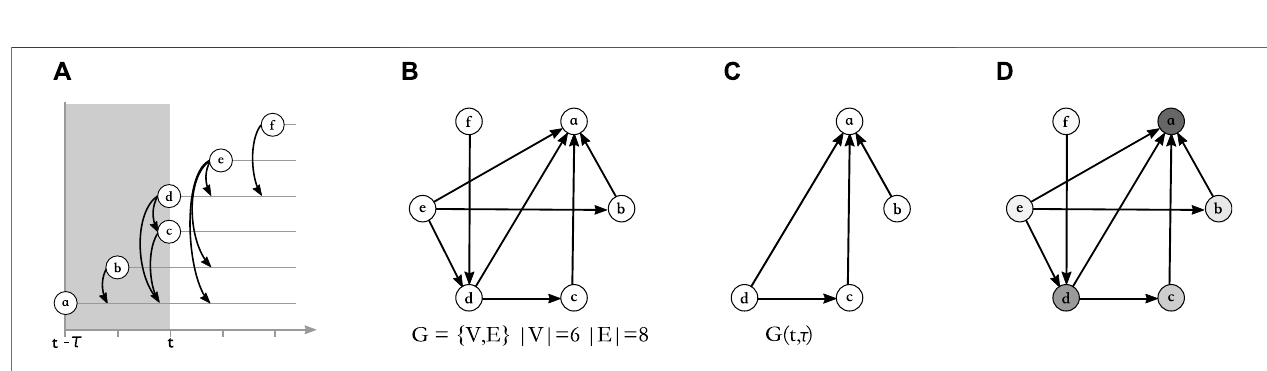
FIGURE 4 | Temporal graph. (A) Windowing procedure to construct the graph G ( t , τ ) (B) Completegraph Gwith 6nodesand 8 edges (C) Sub-graph G ( t , τ ) ⊂ G (D) Authority score. Example where the shade of each node represents its Authority score. Node a has high